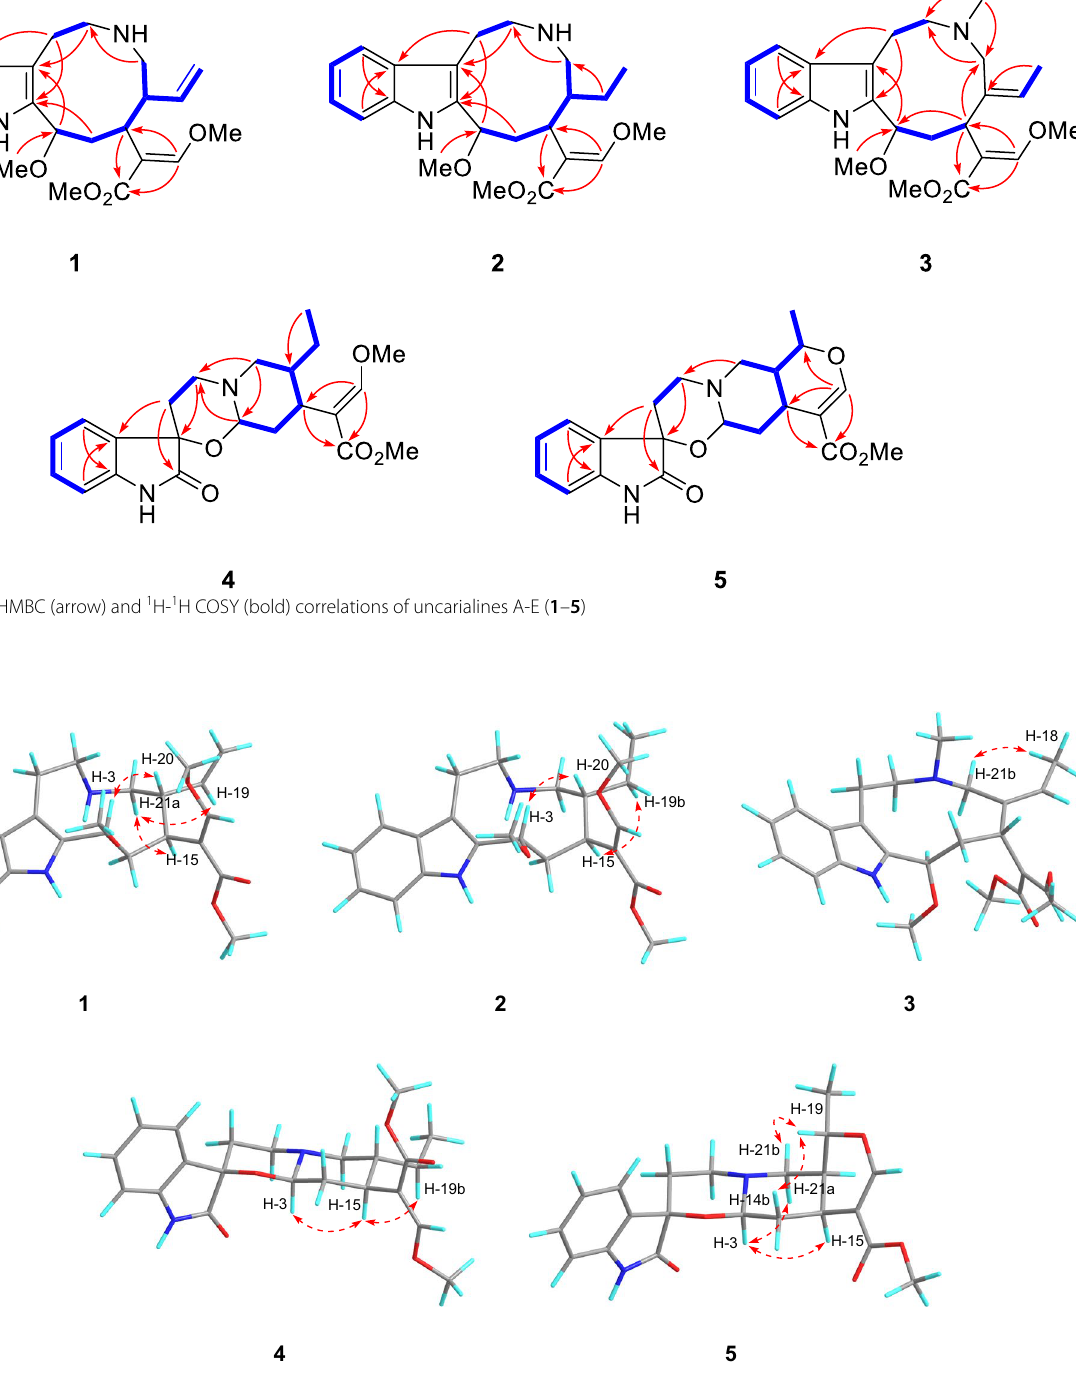
Fig. 3 Key ROESY correlations of uncarialines A‑E ( 1 – 5